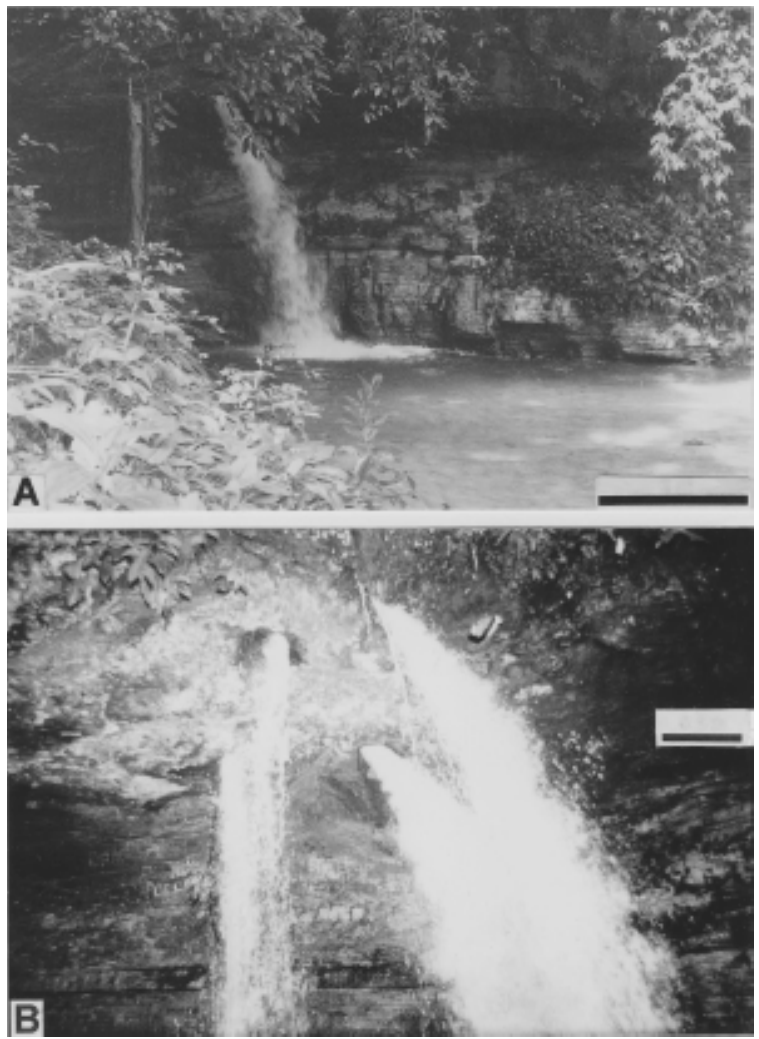
Fig. 6 – Pedra Furada Waterfall. A) The general aspects and rock of the wall repre- sented by interbedded shales and basal stratified sandstones and massive sandstone in the top perforated by two sinks (dry period). Scale bar is 3m. B) Detail of the sinks (in plant) in flood period. Scale bar is